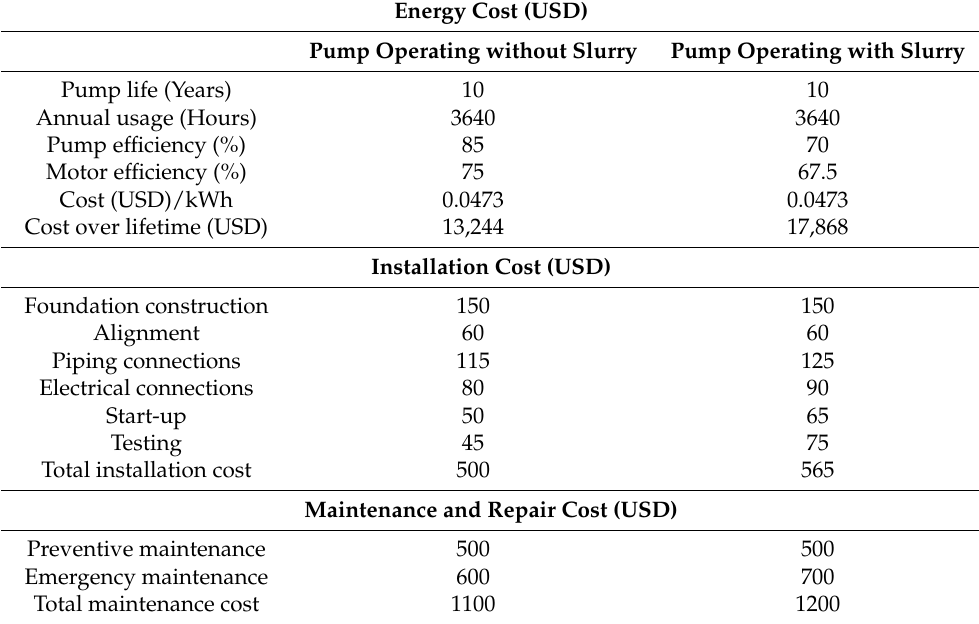
Table 5. Installation, energy and maintenance cost comparison for a single